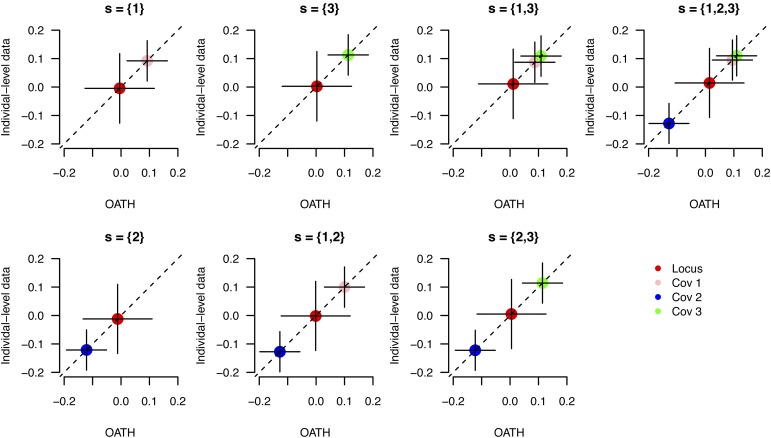
Demonstration of OATH for a single locus. Three covariates were simulated, and OATH generated seven models by including one, two, or three covariates. The subtitle for each plot indicates the set of covariates included. The x-axis represents the regression coefficients estimated from OATH, whereas the y-axis shows the regression coefficients for the corresponding model but estimated from the individual-level data. The vertical and horizontal lines across each point indicate the SE of the partial regression coefficient estimated via OATH and individual-level data, respectively. The subtitle in each panel indicates the covariates included. OATH, Open GWAS algoriTHm.